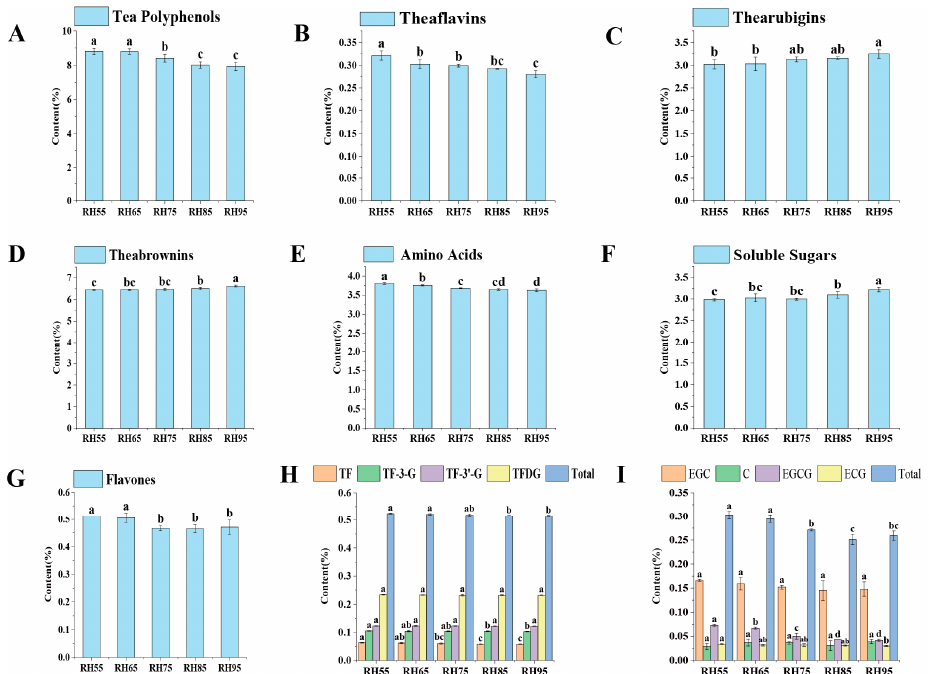
Figure 3. Content of tea polyphenols ( A ), theaflavins ( B ), thearubigins ( C ), theabrownins ( D ), amino acids ( E ), soluble sugars ( F ), fl avones ( G ), four main monomers (TF, TF-3-G, TF-3’-G, TFDG) of theaflavins and their total ( H ), and four main monomers (EGC, C, EGCG, ECG) of catechins and their total ( I ) in different treatments. Significant differences at p < 0.05 are indicated by different lowercase le tt ers.